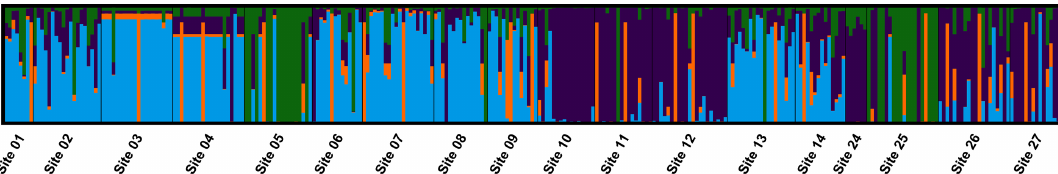
Figure 6. Clumpak output summarising eight replicate fastStructure runs for K = 4, which was optimal across a range of K2–K18. Genetic structure is evident between Sclerolaena napiformis sites to the east (sites 1–9 and 13–14) and west (sites 10–12 and 24–27) of Marnoo, Victoria.